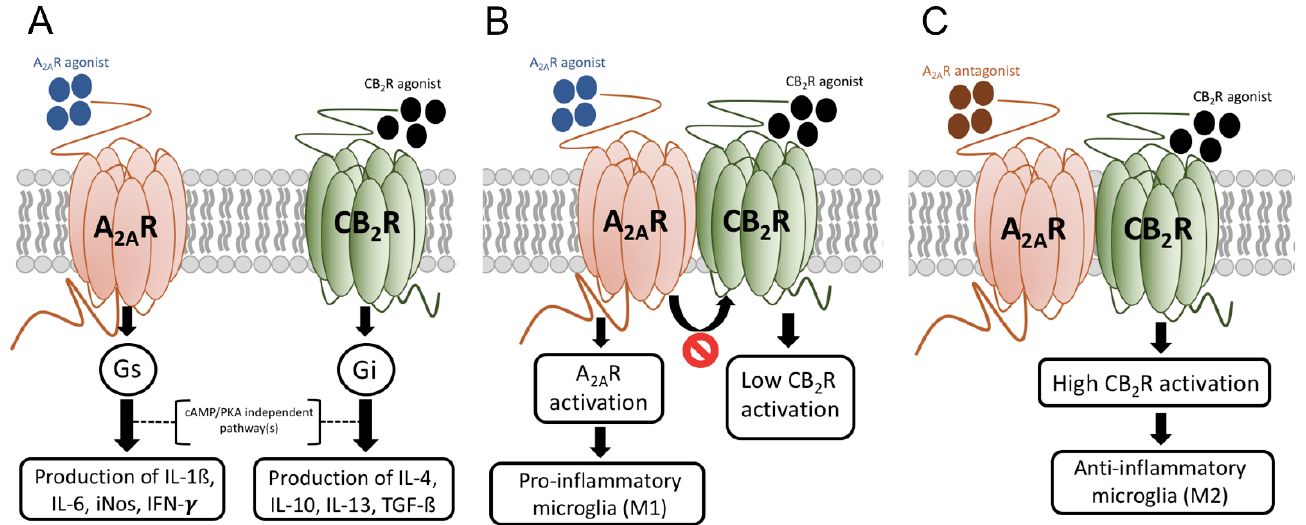
Figure 2. Microglial polarization mediated by adenosine A 2A and cannabinoid CB 2 receptor and by A 2A -CB 2 receptor heteromer. Panel ( A ). By unknown mechanisms unrelated to the cAMP/PKA pathway activation of the A 2A receptor, which couples to Gs, this receptor mediates pro-inflammation, whereas activation of the CB 2 R mediates anti-inflammation/neuroprotection. Panel ( B ). A 2A R agonists acting on microglial receptors are pro-inflammatory. Within the A 2A -CB 2 receptor heteromer, activation of the A 2A R reduces CB 2 R-mediated signaling (negative cross-talk). Panel ( C ). Blockade of the A 2A R is anti-inflammatory in activated microglia but, also, it reverts the negative cross-talk within the A 2A -CB 2 receptor heteromers. Accordingly, A 2A R antagonists are not only anti-inflammatory but potentiate the anti-inflammatory/neuroprotective action of endocannabinoids acting on microglial CB 2 Rs.